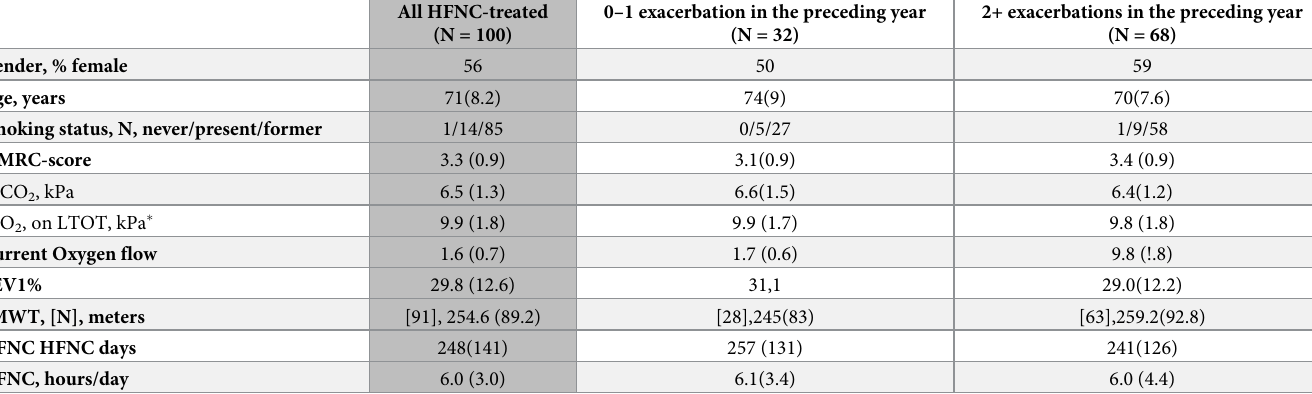
Table 1. Background information on included patients, the entire study population and subgroups. Where nothing else stated data are presented as means (standard deviations).